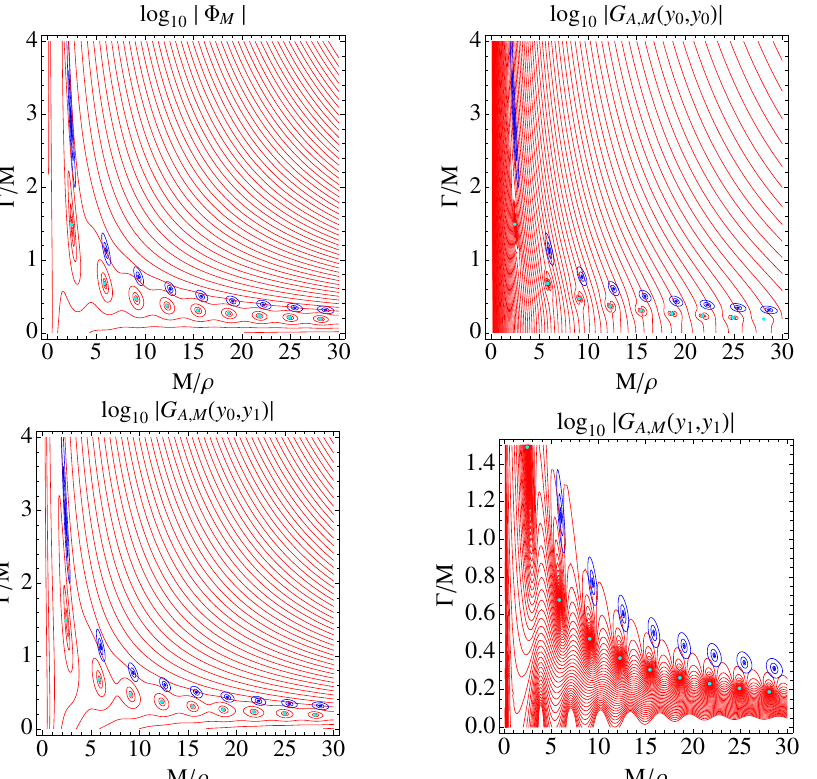
Figure 14 . Upper left panel: contour plot in the plane ( M/ρ, Γ /M ) of log | Φ M ( p ) | cf. eq. (A.4) 10 (red lines). Upper right and lower panels: common logarithm of the absolute value of the Green’s function log | G A,M ( y 0 , y 0 ) | (upper right), log | G A,M ( y 0 , y 1 ) | (lower left) and log | G A,M ( y 1 , y 1 ) | 10 10 10 (lower right). The (cyan) dots stand for the positions of the poles of the Green’s function as predicted by the analytical formula of eq. (A.23). For comparison, the positions of the zeros of Φ( p ) in the massless case, cf. figure 4, are displayed in blue in each panel. We have considered ρ = 1 TeV, m Z = 0 . 091 TeV and A 1 = 35